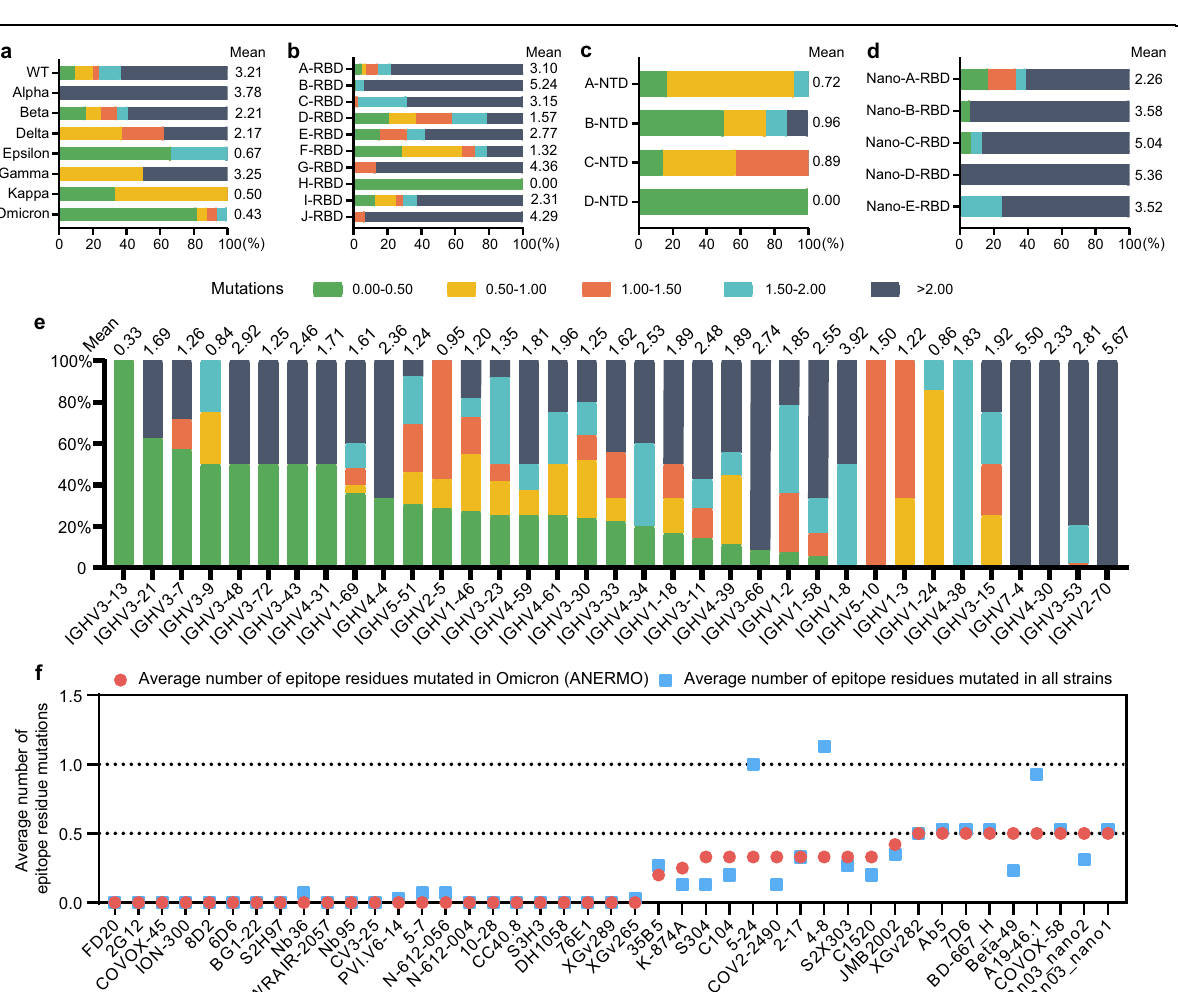
Fig. 2 Epitope mutation statistics in Omicron. a Epitope mutations in Omicron of antibodies targeting different strains. The ANERMO of the antibodies targeting each strain are listed at the top of the columns. b The ANERMO from different RBD antibody structural classes. c The ANERMO from different NTD antibody structural classes. d The ANERMO from different RBD nanoantibody structural classes. e The ANERMO from different heavy chain genotypes. f Statistics of the potential broad-spectrum antibodies. Red points stand for ANERMO; blue squares stand for average number of epitope residues mutated in WT, Alpha, Lambda, Beta, Delta, Kappa, Gamma, and Omicron